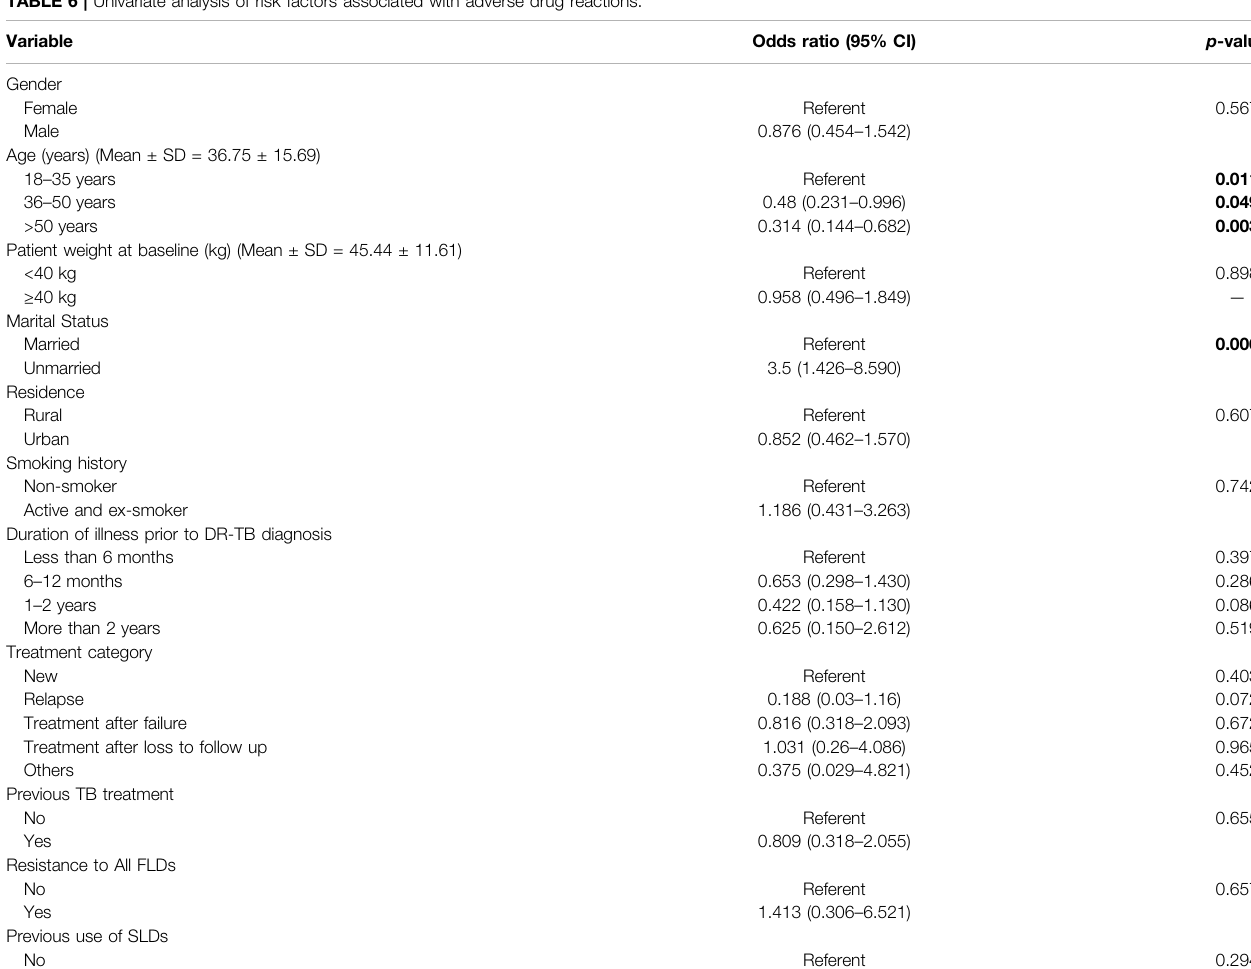
TABLE 6 | Univariate analysis of risk factors associated with adverse drug